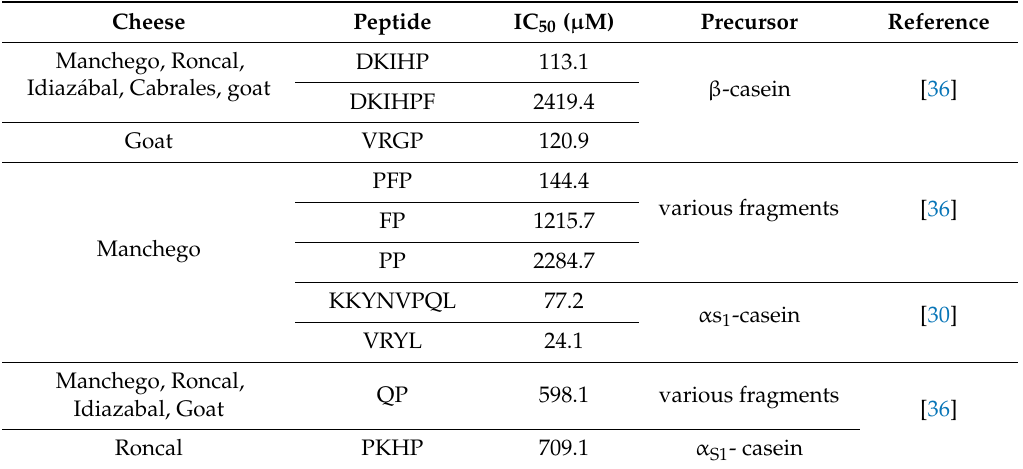
Table 3. ACE inhibitors identified in Spanish cheeses. Adapted by permission from Springer, European Food Research and Technology [36], 2006. Cheese Peptide IC 50 ( µ M) Precursor